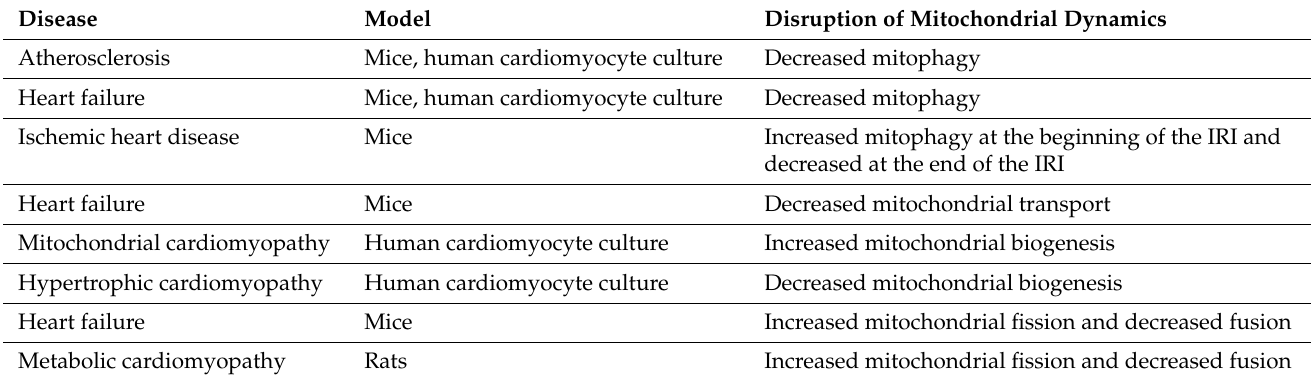
Table 1. Studies of mitochondrial dynamics disorders in